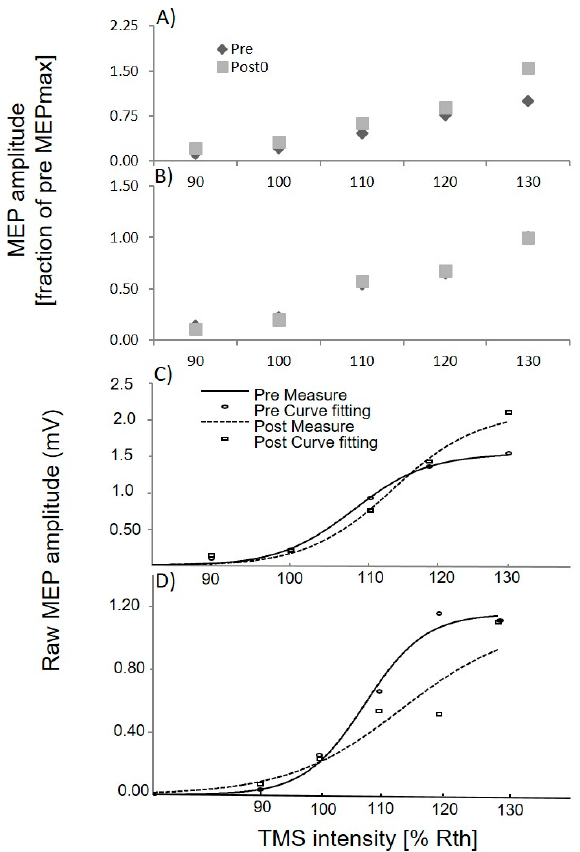
Figure 1. Motor evoked potential (MEP) recruitment curve for the upper limb muscle (APB) across all subjects, ( A ) prior to (pre), and following (post0) the cervical manipulation intervention. ( B ) Control Passive head movement group. Raw and fitted MEP recruitment curve for APB: ( C ) prior to, and following the cervical manipulation intervention for n = 1; and ( D ) prior to, and following the PHM for n = 1.